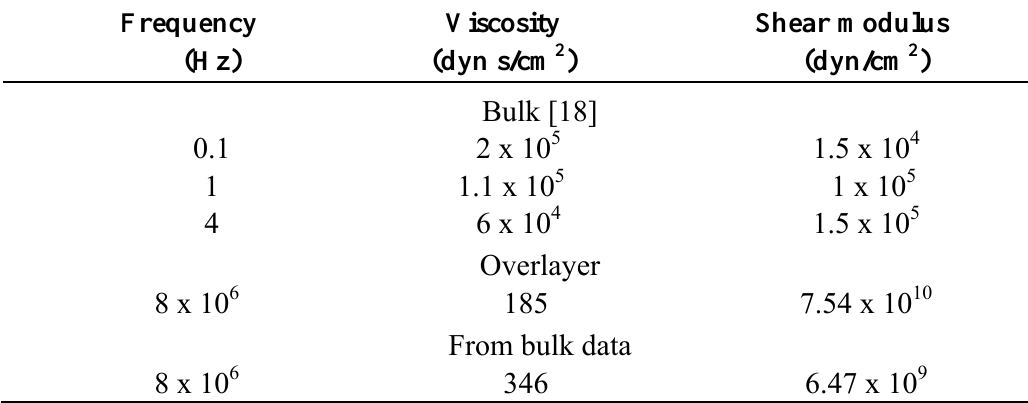
Table 1. Experimental and estimated values of viscosity and elastic shear